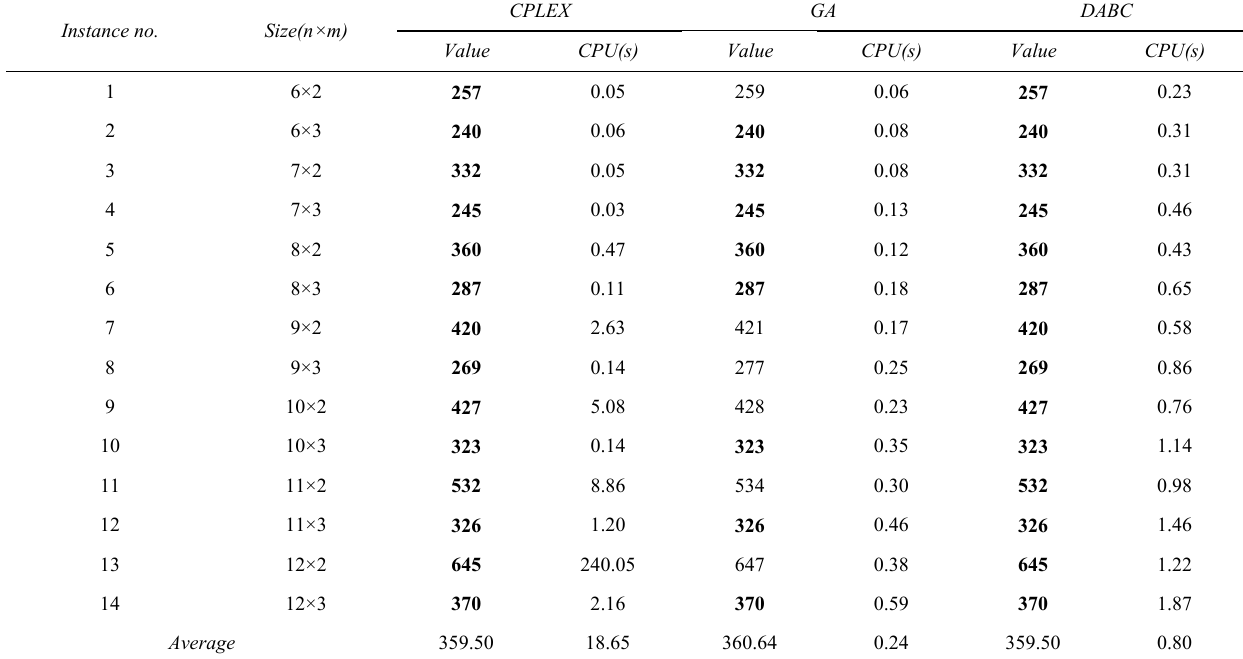
Table 3. Results of random instances with small